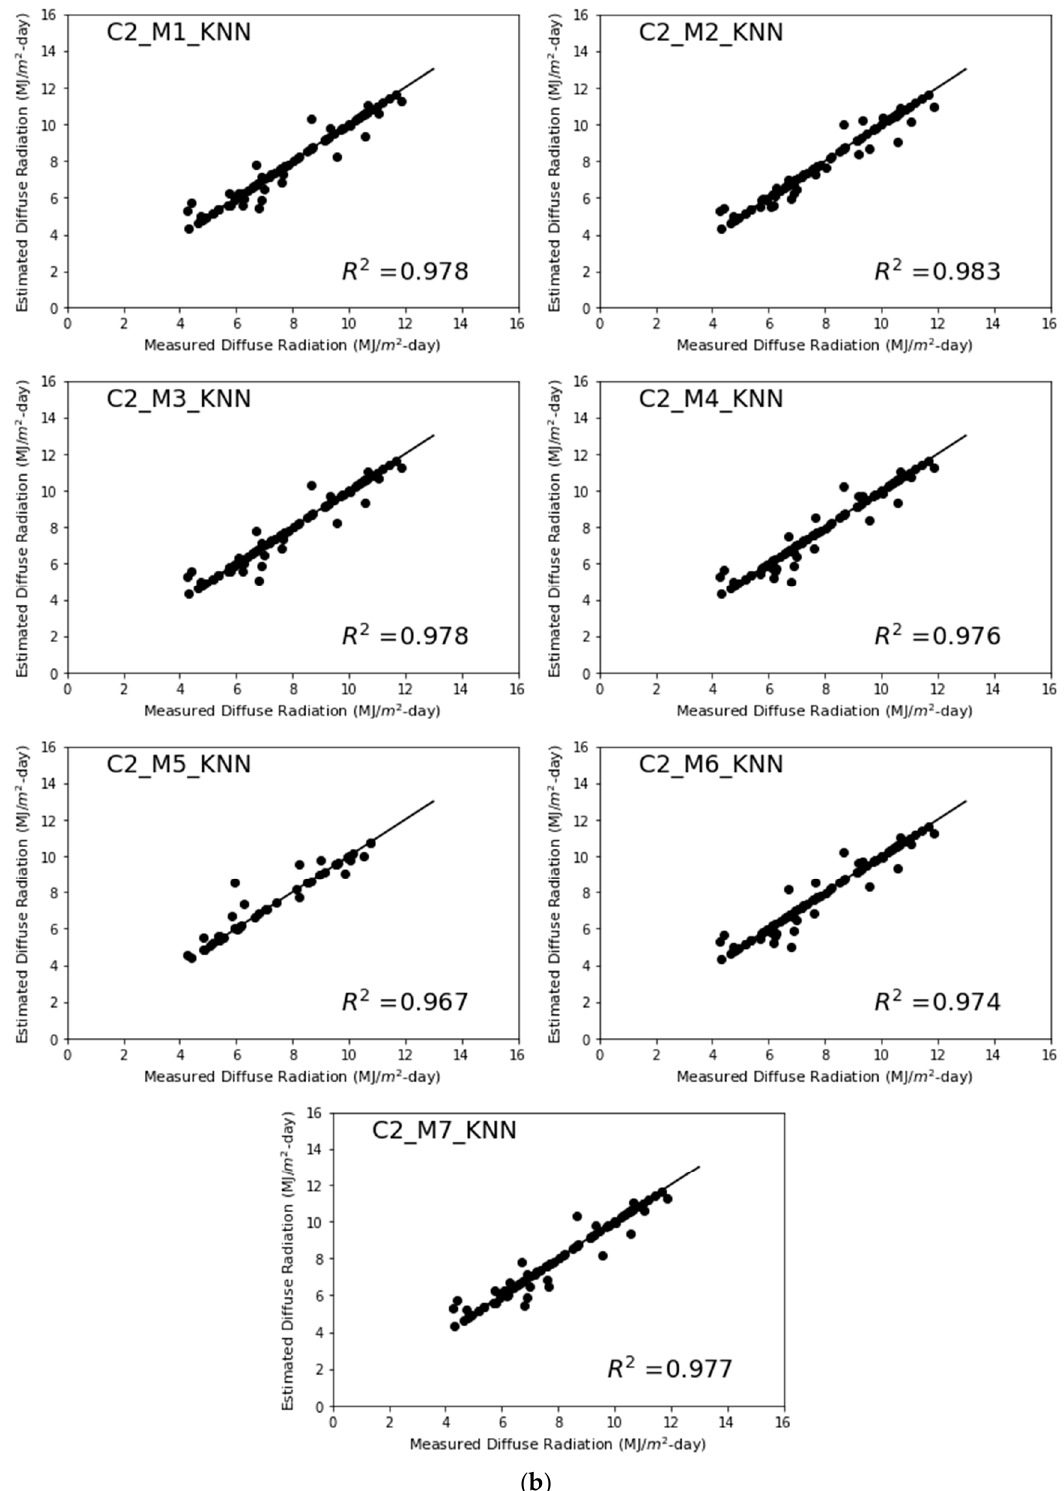
Figure 9. ( a ) Plot depicting predicted and measured DSR tropical wet and dry climate (Category I). ( b ) Plot depicting predicted and measured DSR tropical wet and dry climate (Category 2).